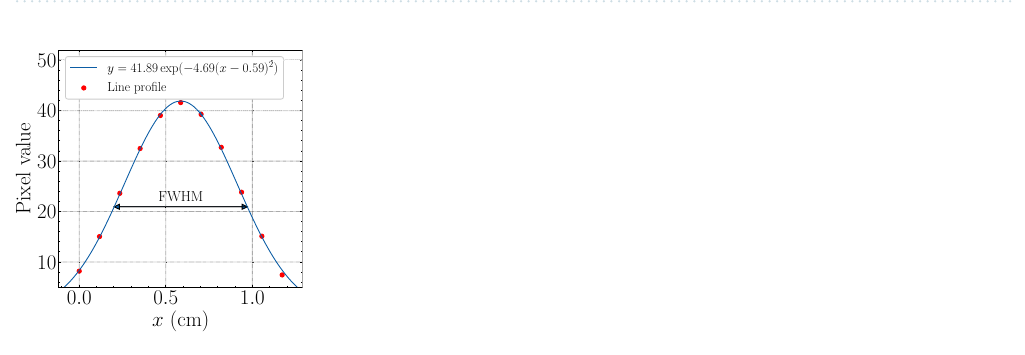
Figure 4. Gaussian fit of the average line profile. FWHM of the fitted Gaussian is shown as the arrow. The 11 pixels around the pin center shown as the red points were used in the fitting. The coefficient of determination R 2 of the fit was